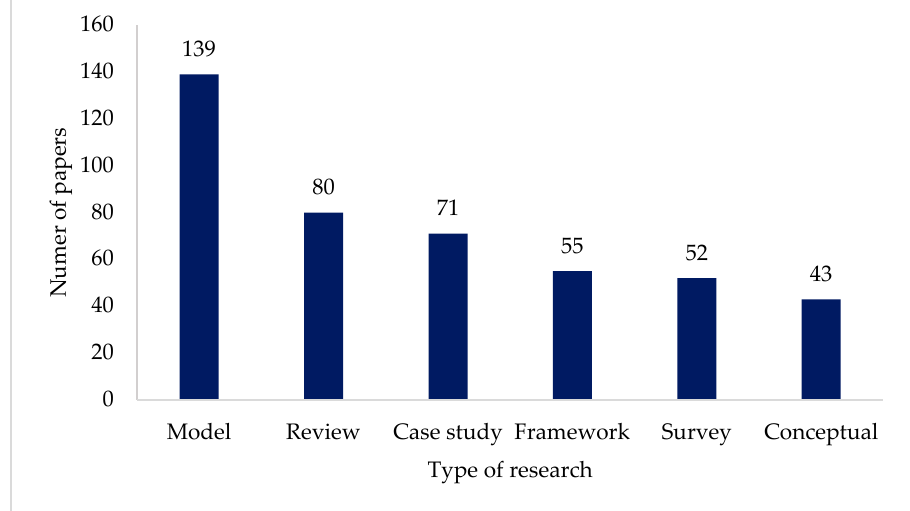
Figure 5. Distribution of articles based on the type of research.